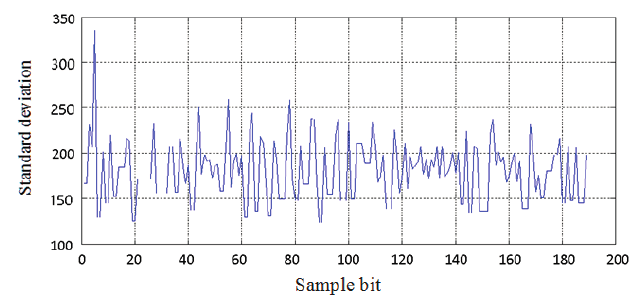
Figure 5. Standard deviation of measurement for sample